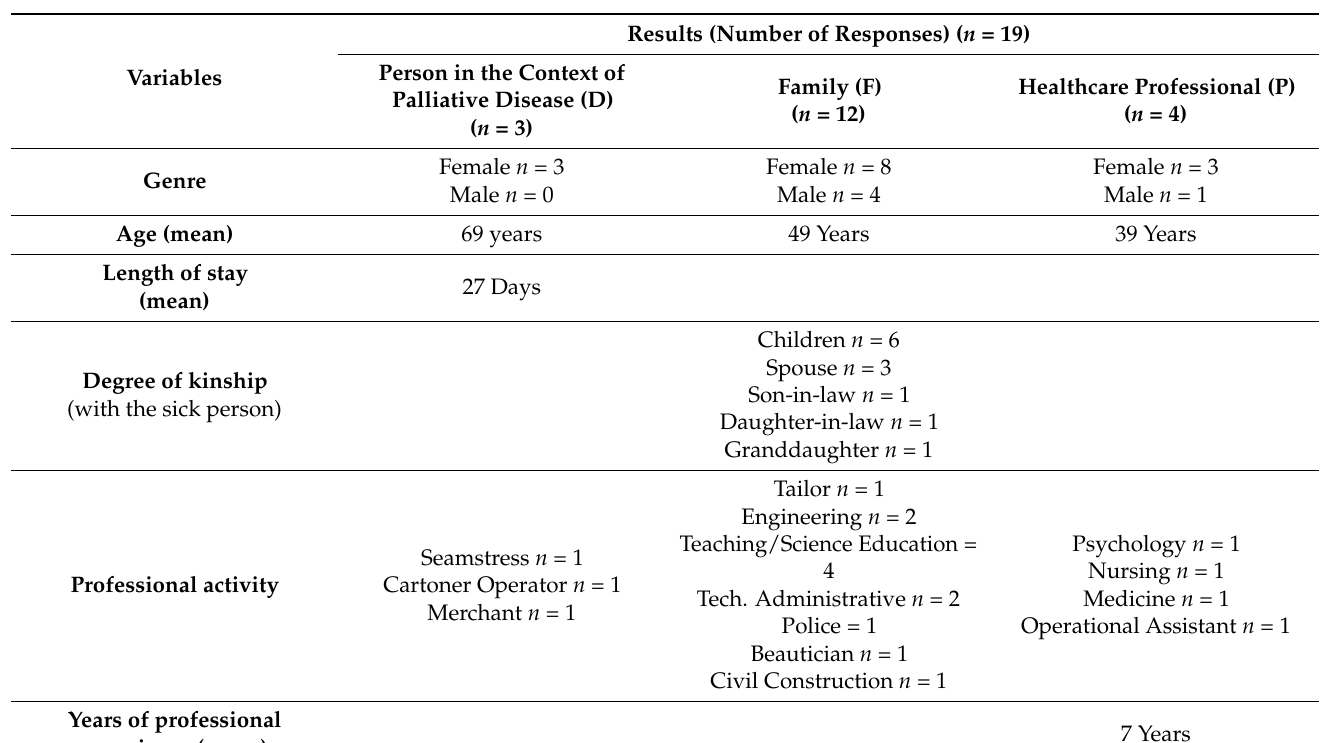
Table 2. The socio-demographic characterization of “ Pallium Game ”